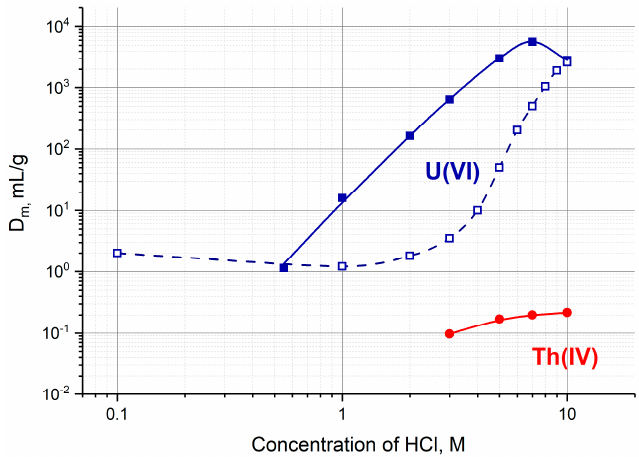
Figure 2. The mass distribution ratios D m , mg/mL, of U(VI) and Th(IV) on TEVA resin (solid lines) [31] and Dowex 1 × 10 (dashed line) [33] as a function of HCl concentration.